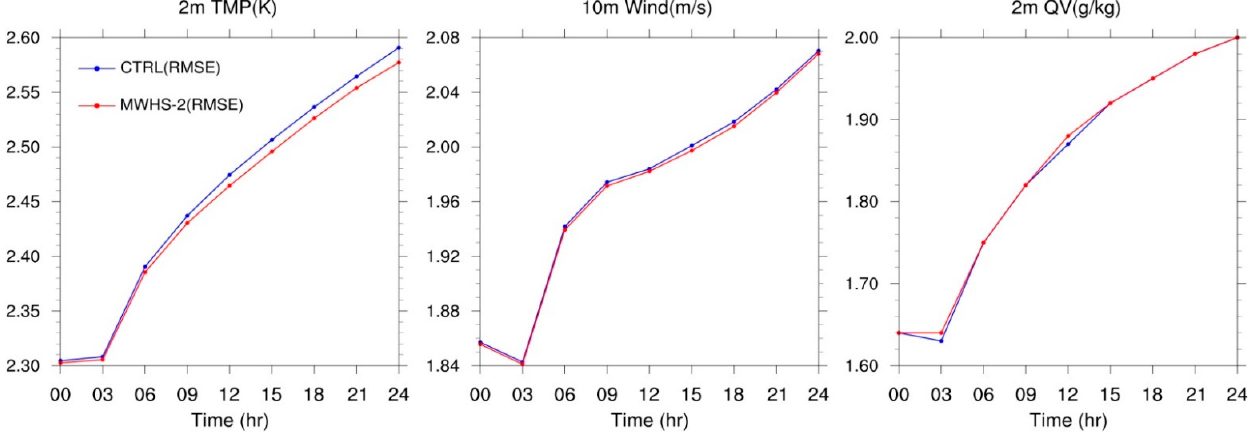
Figure 9. RMSEs of the temperature (TMP) at 2 m ( left ), the wind at 10 m ( middle ), and the humidity (Qv) at 2 m ( right ) over the forecast time of 0–24 h against observations for CTRL (blue) and MWHS-2 (red) experiments.